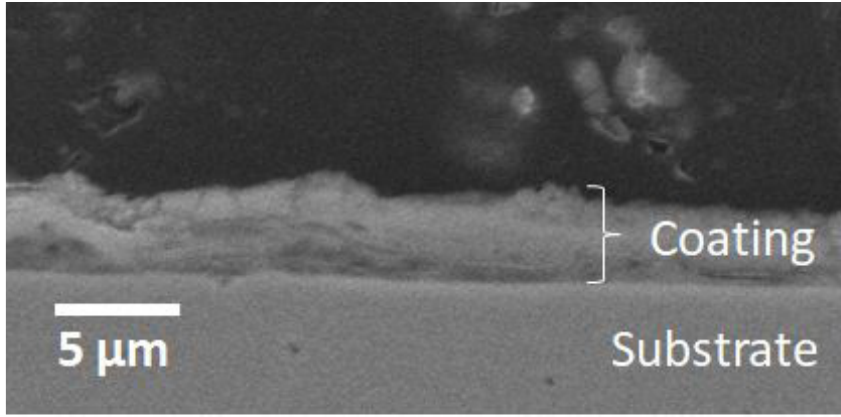
Figure 2. SEM cross-section image of LSC coated